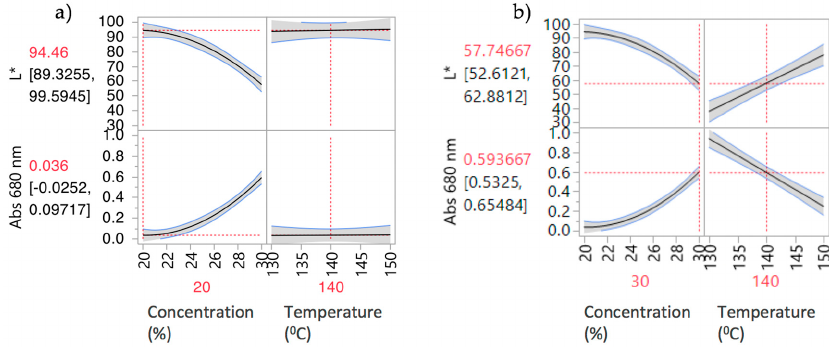
Figure 5. Prediction Profilers for DoE2 ( a ) 20% w / w and ( b ) 30% w / w concentrations.